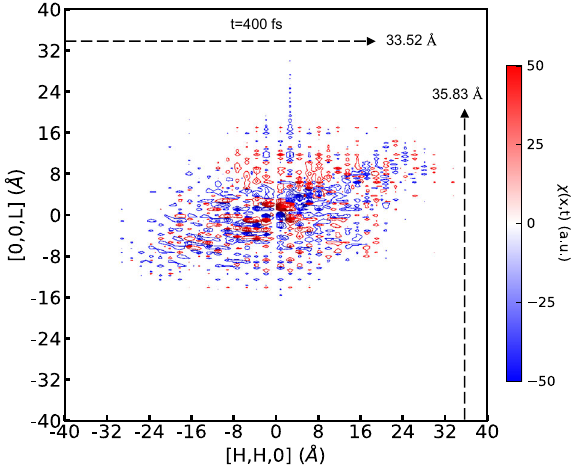
Fig. 5 Snapshot of χ (x, t ) in the ( H , H , L ) plane at t = 400 fs for silicon. The dotted lines represent the extent to which there are disturbances in [1, 1, 0] and [0, 0, 1] directions, which is given by the dispersion of longitudinal acoustic mode at the zone-center.